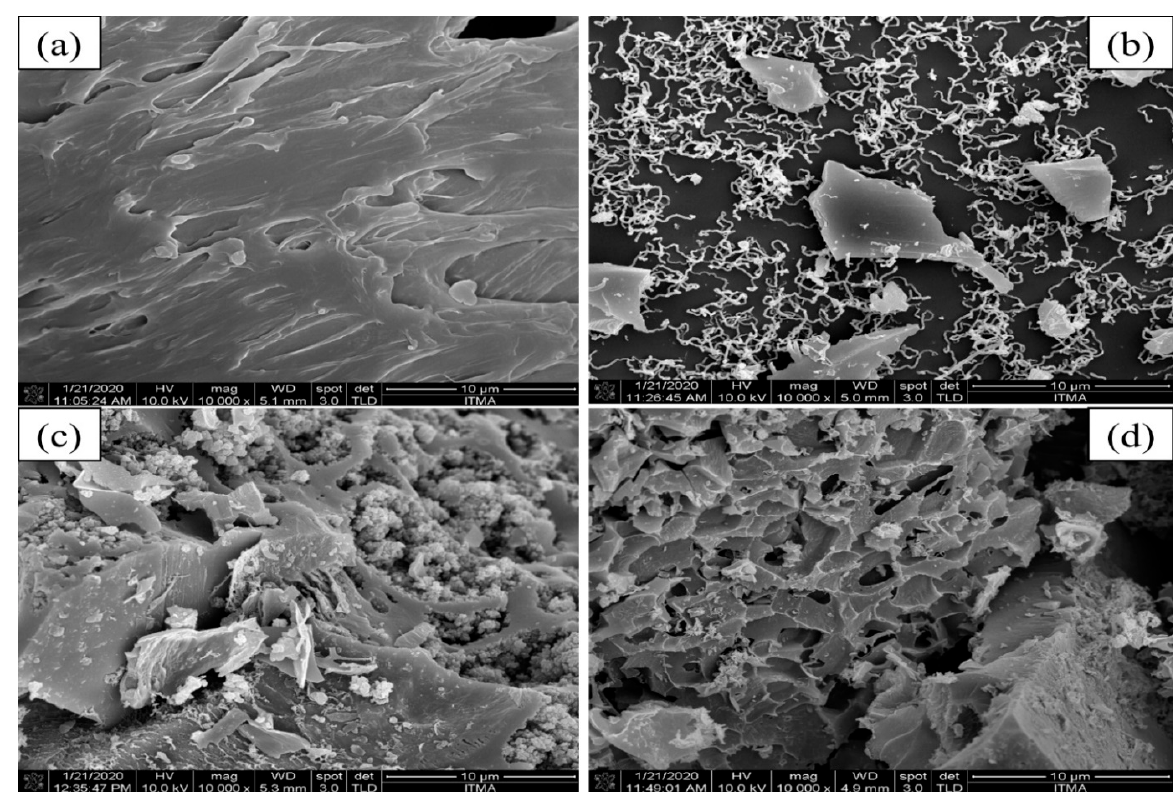
Figure 2. Morphological FESEM images of Raw PET and activated carbon from PET (10,000× magnification): ( a ) PET Raw, ( b ) PET Plain, ( c ) PET H 3 PO 4 and ( d ) PET KOH.